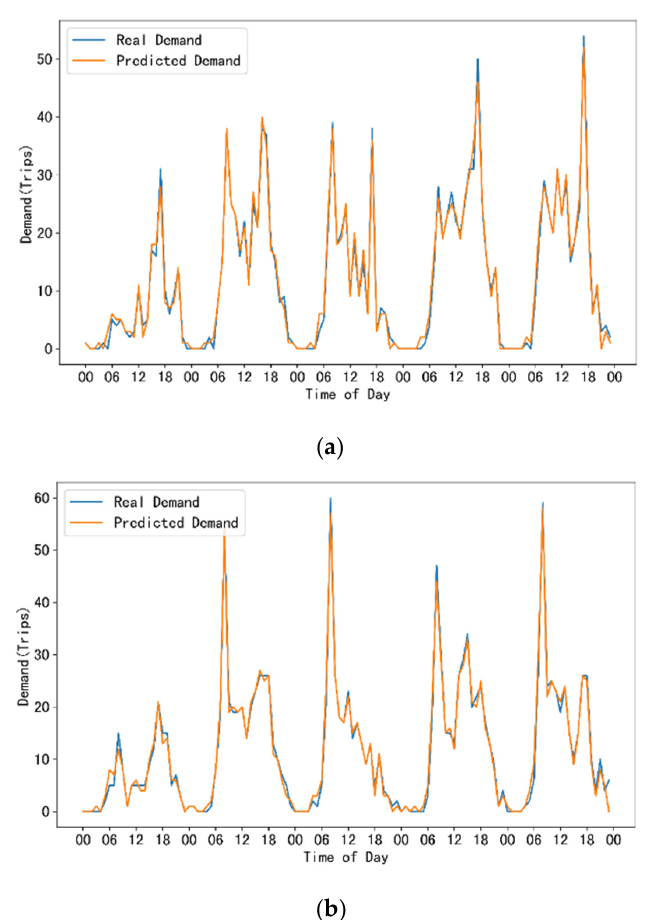
Figure 4. Performance of the rental and return demand prediction. ( a ) Real rental demand and predicted rental demand at station No. 125; ( b ) Real return demand and predicted return demand at station No. 125.